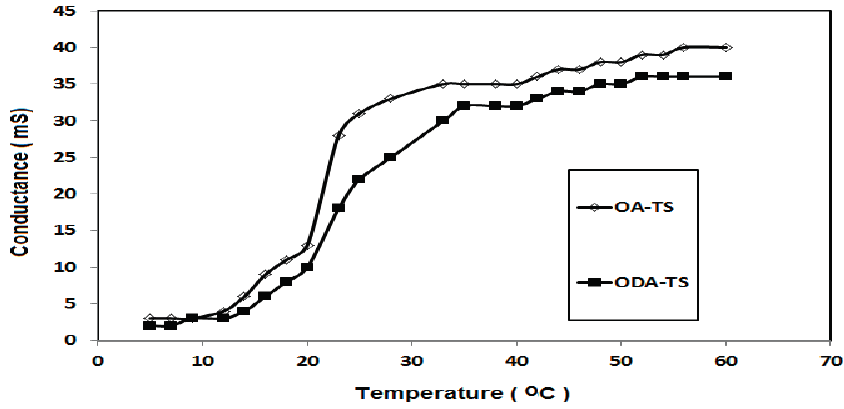
Figure 3. Relation between conductance of ODA-TS and OA-TS and solubility temperature at concentration of 1 mmol·dm − 3